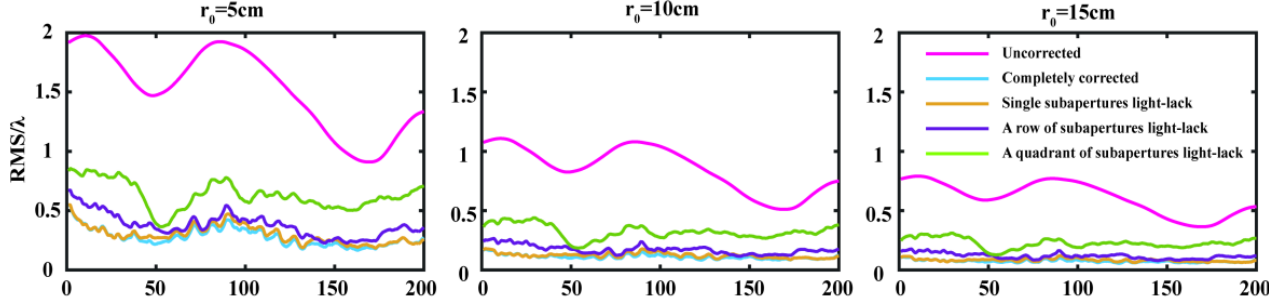
Figure 7. Correction results of 200 frames of different situations of under-samplings, for r 0 , are 5 cm, 10 cm, and 15 cm, respectively. The pinkish-red line represents the uncorrected aberrant wavefront distorted by turbulence. The blue line represents the results that turbulence was corrected with all the sub-apertures illuminated. The yellow line represents a single sub-aperture lack of light. The purple line represents a row of sub-apertures lack of light. The green line represents a quadrant of sub-apertures lack of light.